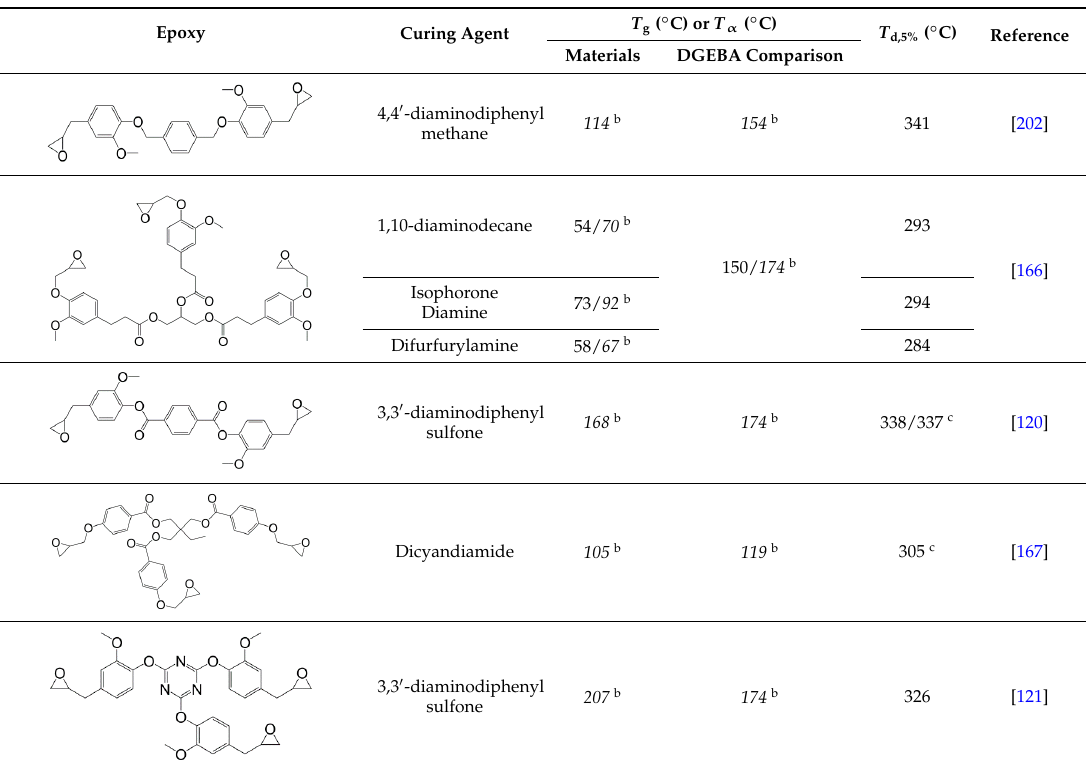
a T a T α measured by DMA at the peak position of loss modulus curve; b T α measured by DMA at the α measured by DMA at the peak position of loss modulus curve; tan δ ; c T d under air maximum of tan δ ; c T d under air flow.